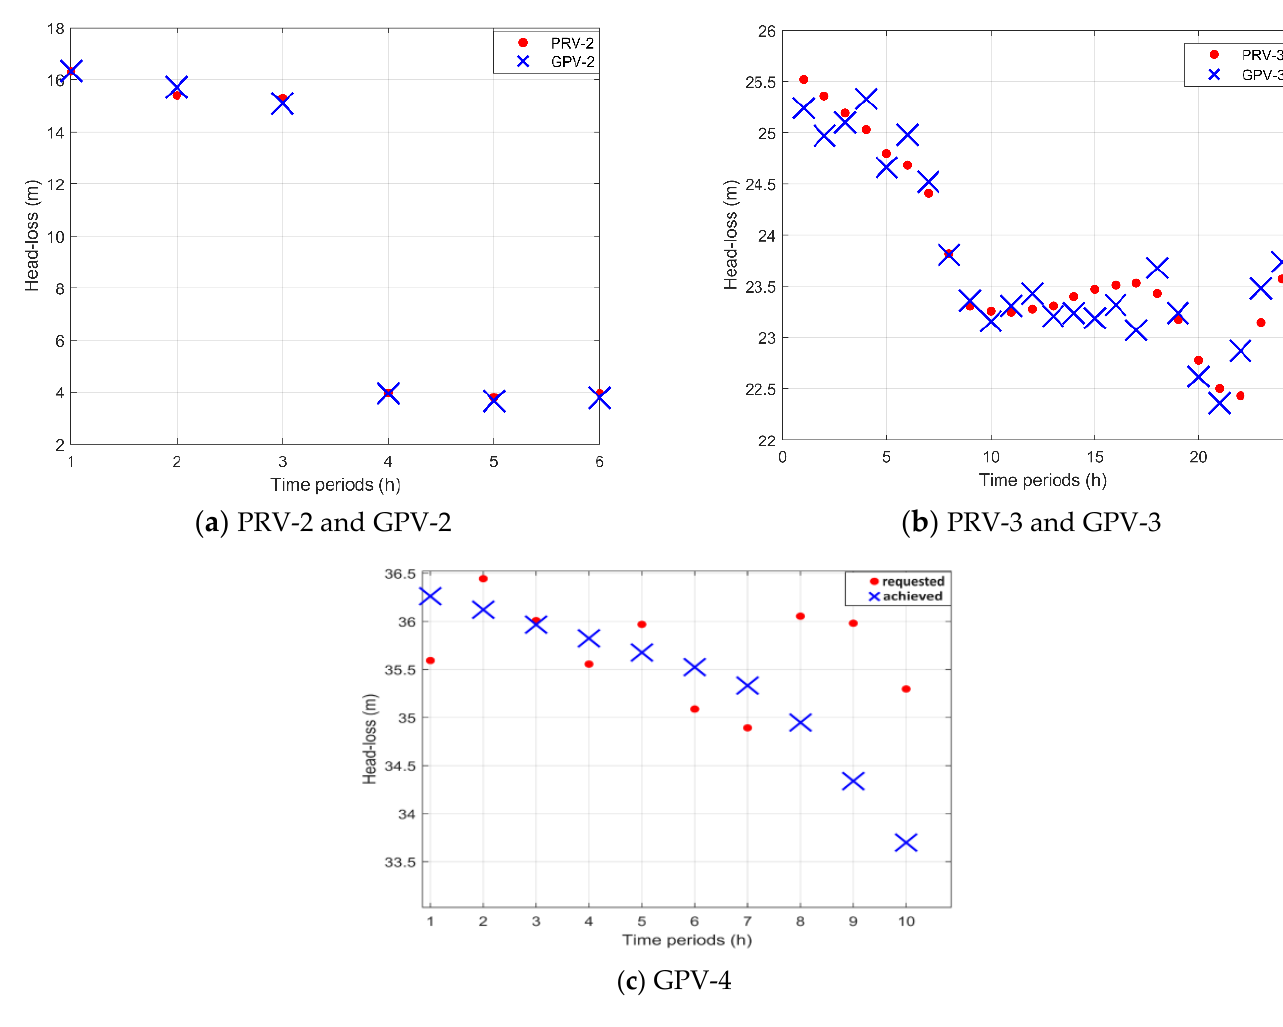
Figure 15. Requested and achieved head loss for all GPVs.